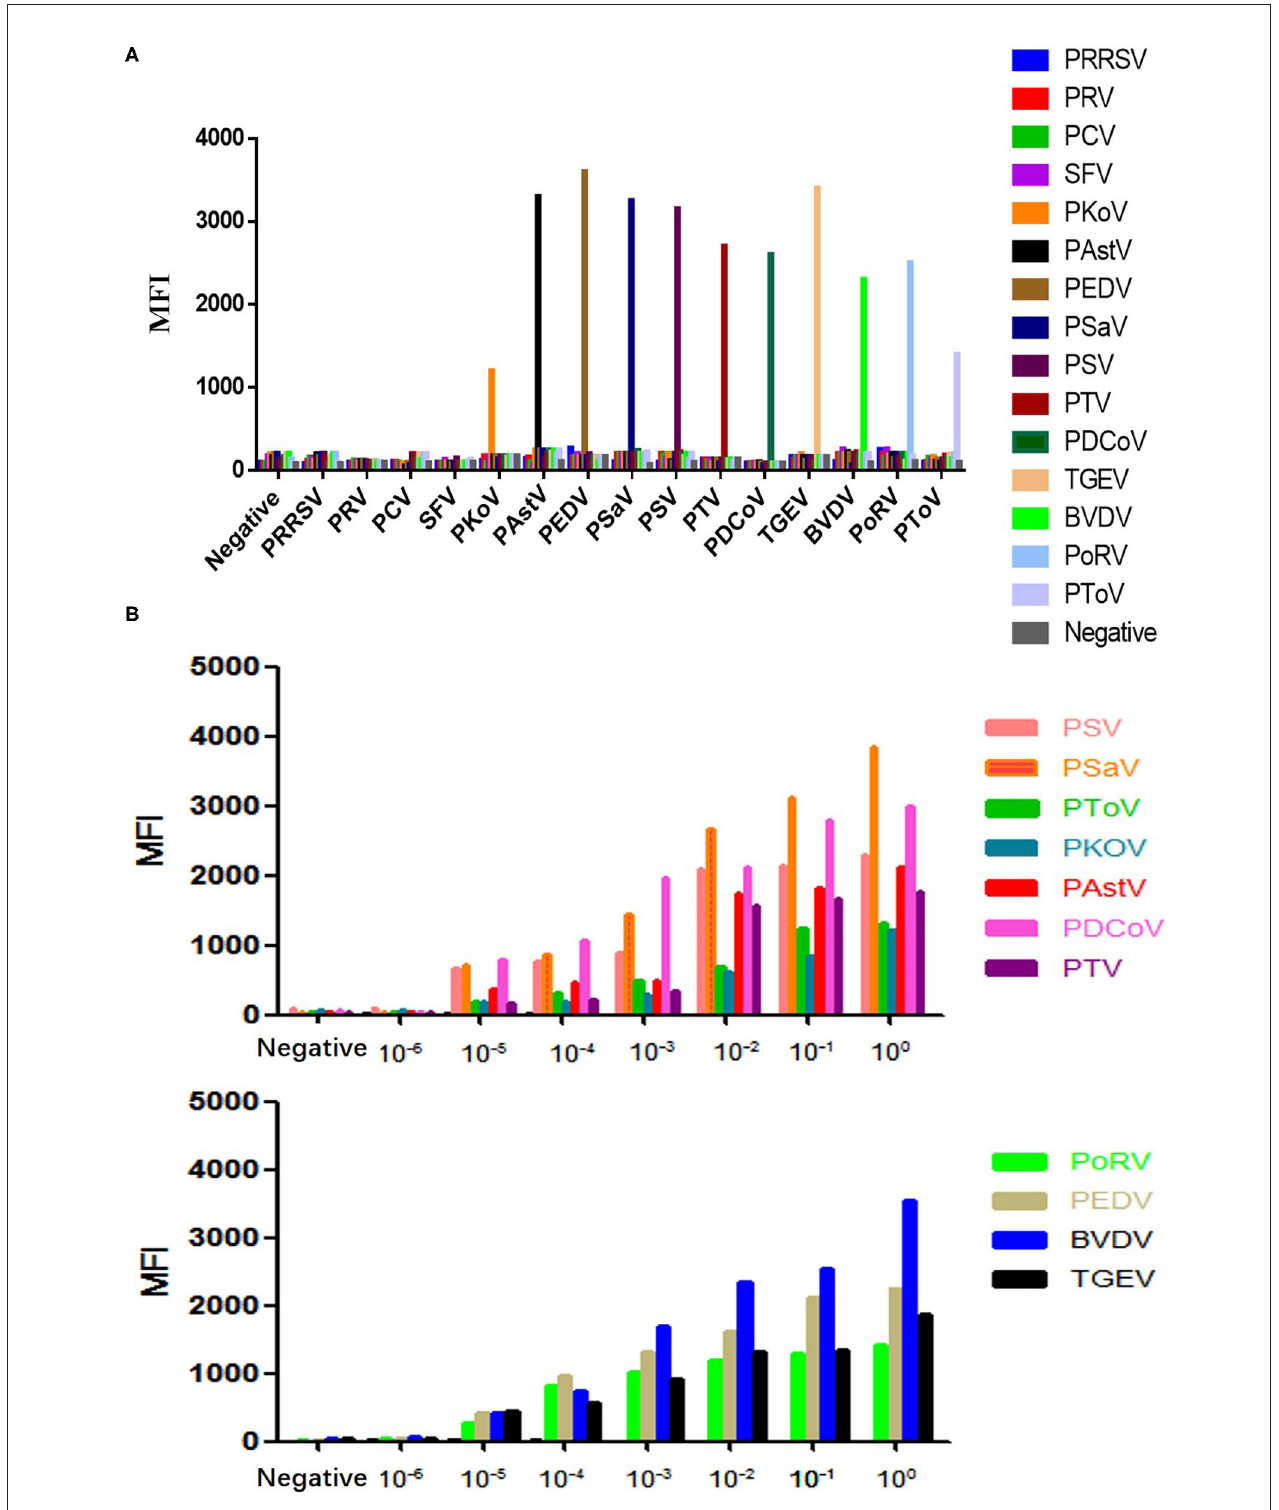
FIGURE 1 | The specificity and sensitivity detection of the Luminex test. (A) The specificity detection. (B) The sensitivity detection.